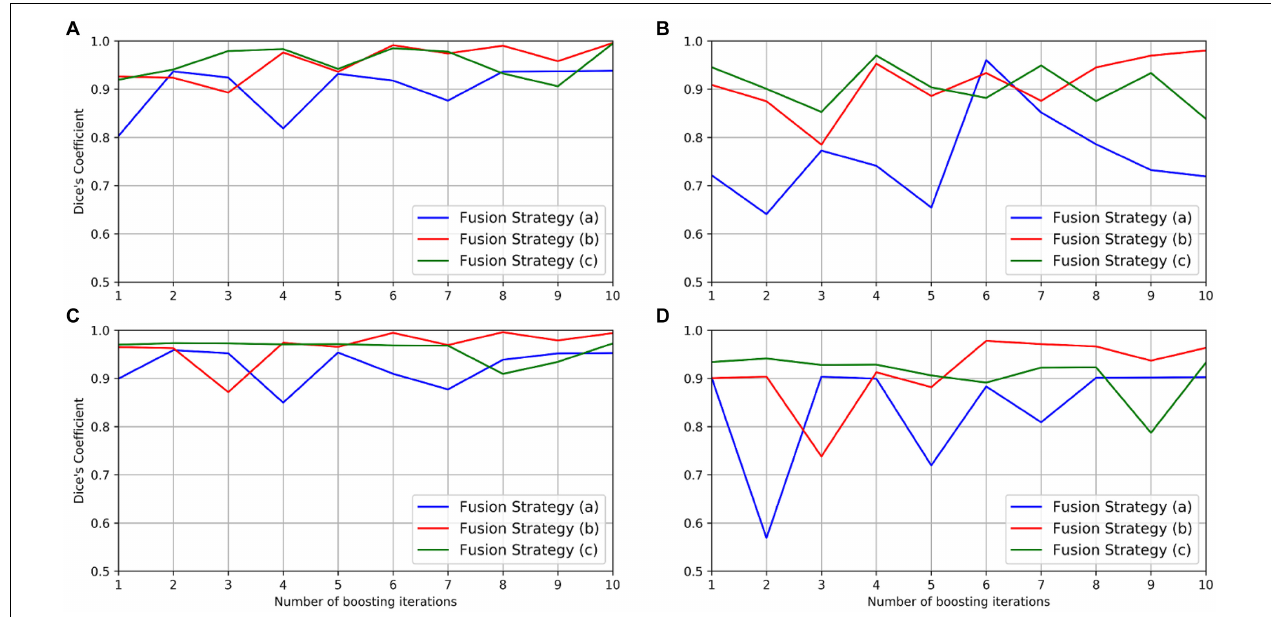
FIGURE 6 | Performance of the boosting framework during 10 iterations: mean DC for somata (A) and vessels (B) in the gold standard set. The results from three different fusion strategies are indicated by blue, red, and green solid lines. The performance on the test set is also shown for somata (C) and vessels (D)